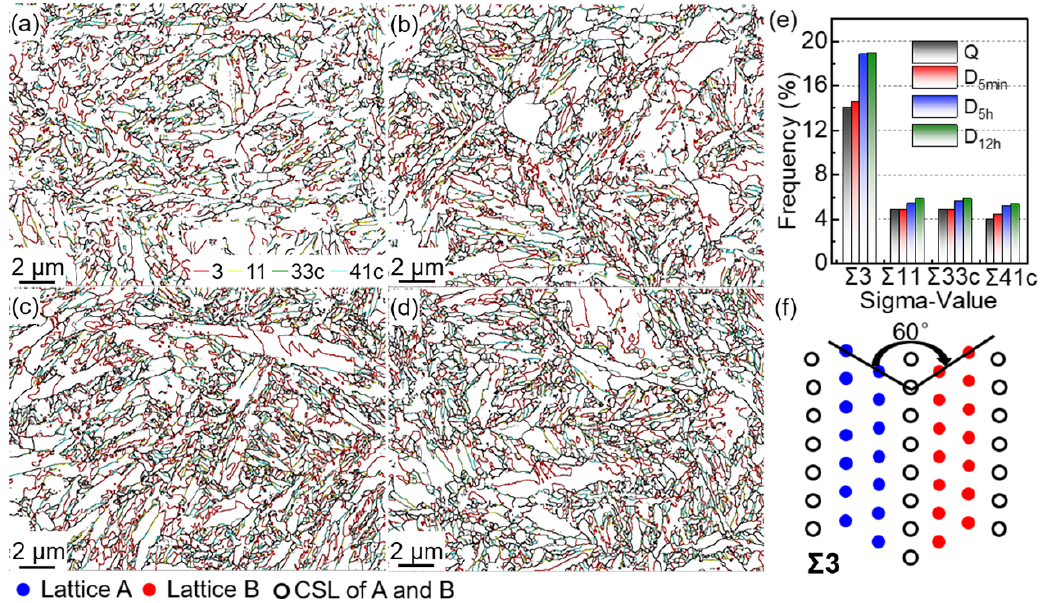
Figure 11. Martensitic CSL (coincident-site lattice) boundary maps in ( a ) Q, ( b ) D 5min , ( c ) D 5h , and ( d ) D 12h , ( e ) the distribution of CSL boundaries, and ( f ) the crystals of Σ 3. Σ 11, Σ 33c, and Σ 41c represent the crystals, which are rotated with the same dot structure by 50.48°, 58.98°, and 55.88°, relative to the other crystal in the [111] crystal band axis, respectively. As shown in Figure 11e, the frequency of other CSL boundaries in M ( Σ 11, Σ 33c, and Σ 41c) is much less than Σ 3. Σ 11, Σ 33c, and Σ 41c, which also increase with DCT time, but they show a lower rise than Σ 3.